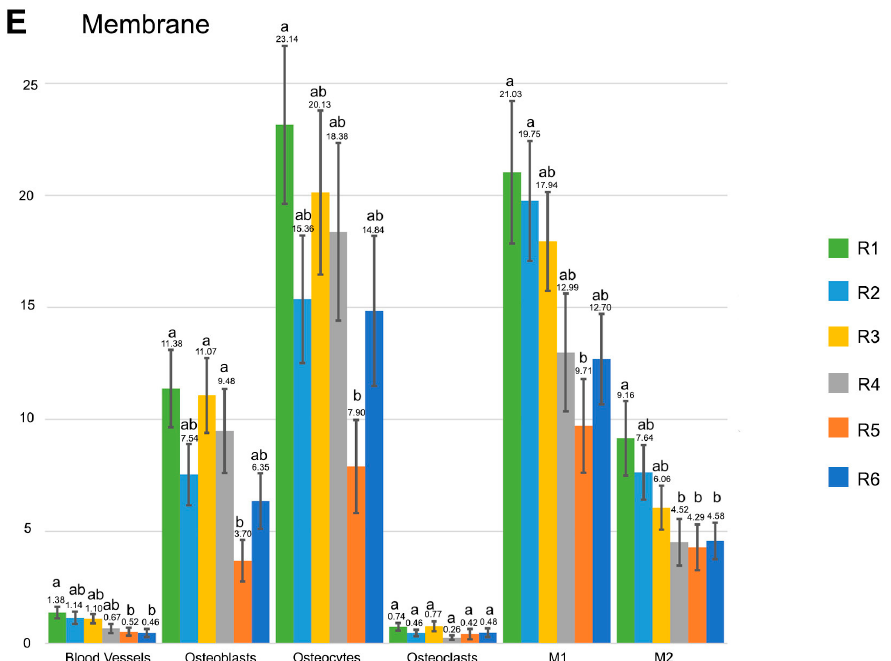
Figure 4. Mean ± Standard Error of blood vessels and bone cells counts at the selected study section within each of the regions into which the defect is divided in ( A ) Si-M, ( B ) Zn-Si-M, ( C ) Dox-Si-M, ( D ) sham group and ( E ) with the presence of membrane. Similar lower-case letters indicate no differences between regions within the same cell group. The numerical data are collected in Supplementary Materials Table S3.